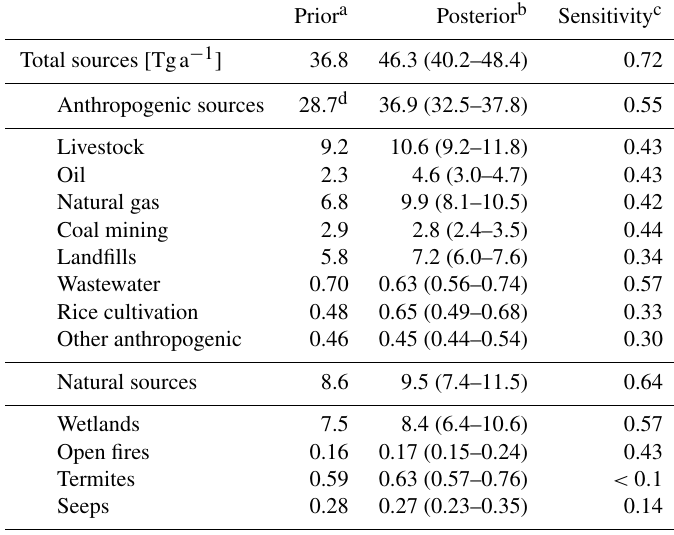
Table 1. (a) Mean 2010–2017 methane emissions for the contiguous US